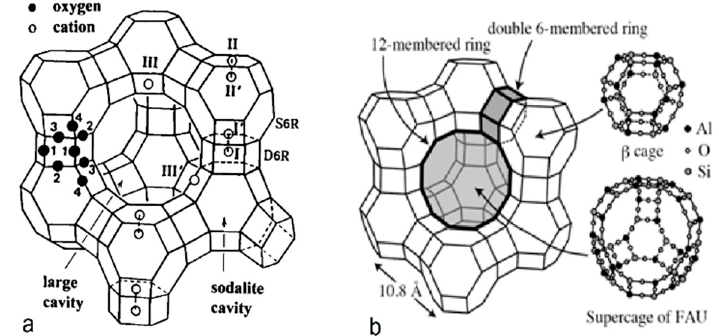
Figure 2. ( a ) Stylized drawing of the framework structure of zeolite-X. Near the center of each line segment is an oxygen atom. The different oxygen atoms are indicated by numbers 1–4. Silicon and aluminum atoms alternate at the tetrahedral intersections, except that Si substitutes for Al in at least 4% of the Al positions. Further long-range mixing is proposed. Extra framework cation positions are labeled with roman numerals [42]. ( b ) Schematic structure of the FAU zeolite-X framework. The small circles with a plus sign indicate possible cation sites [43].